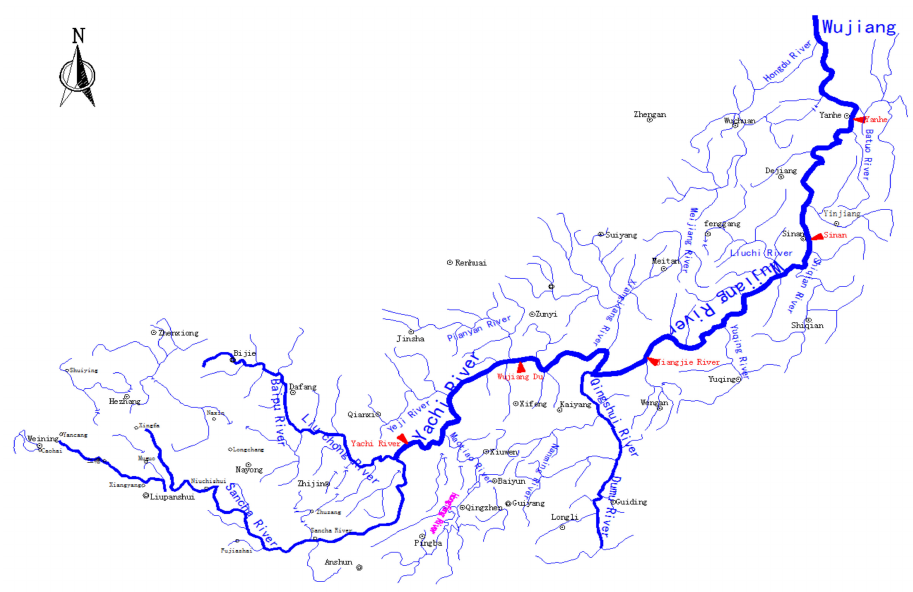
Figure 2. River system map of the Wujiang River Basin.